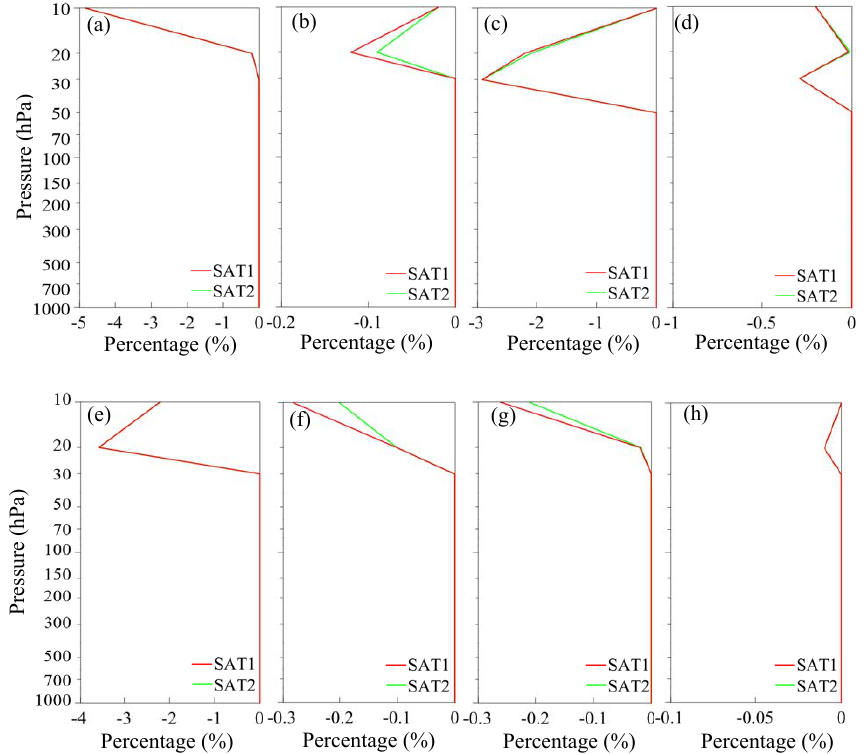
Figure 17. Same to Fig. 14 but for CTRL2, SAT1,